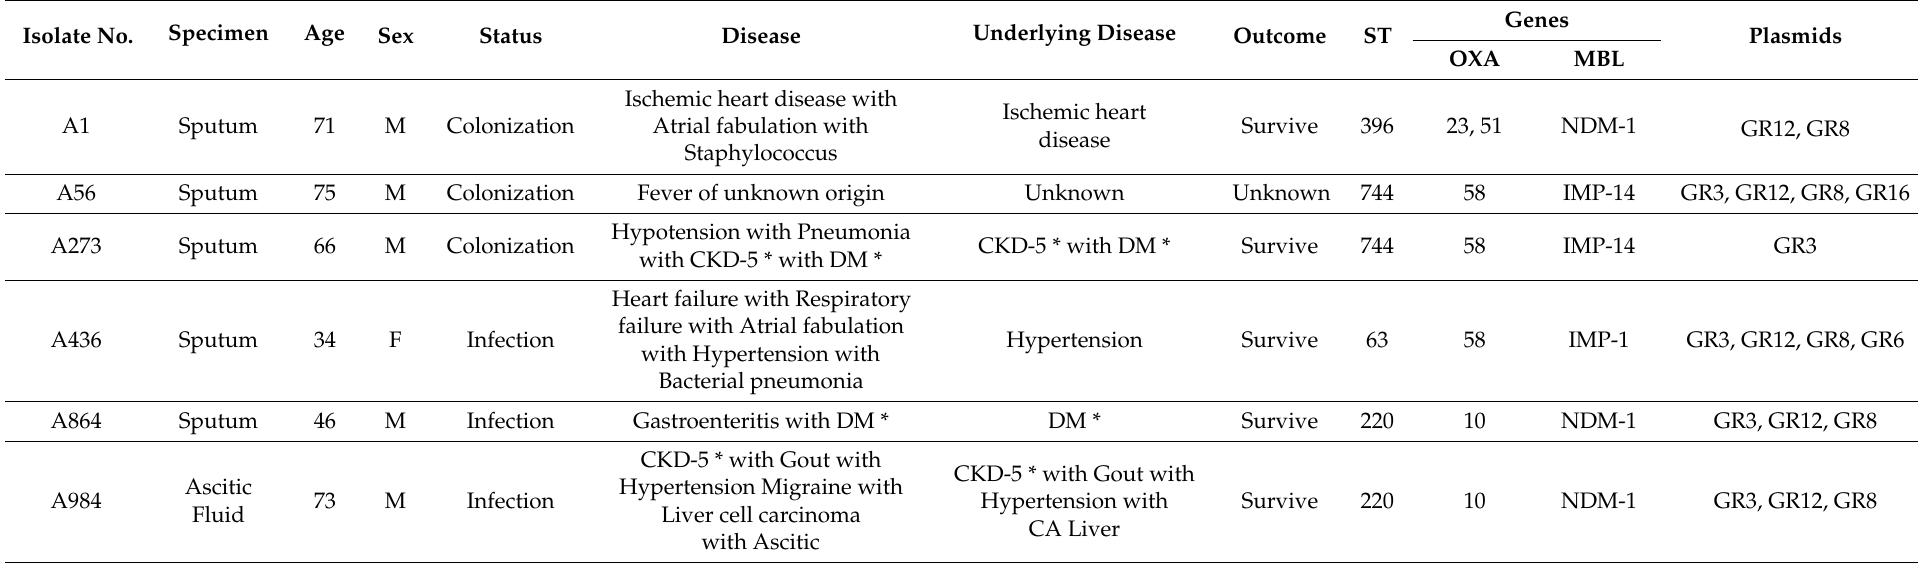
Table 1. Clinical features of 6 Acinetobacter pittii isolates carrying carbapenemase gene.